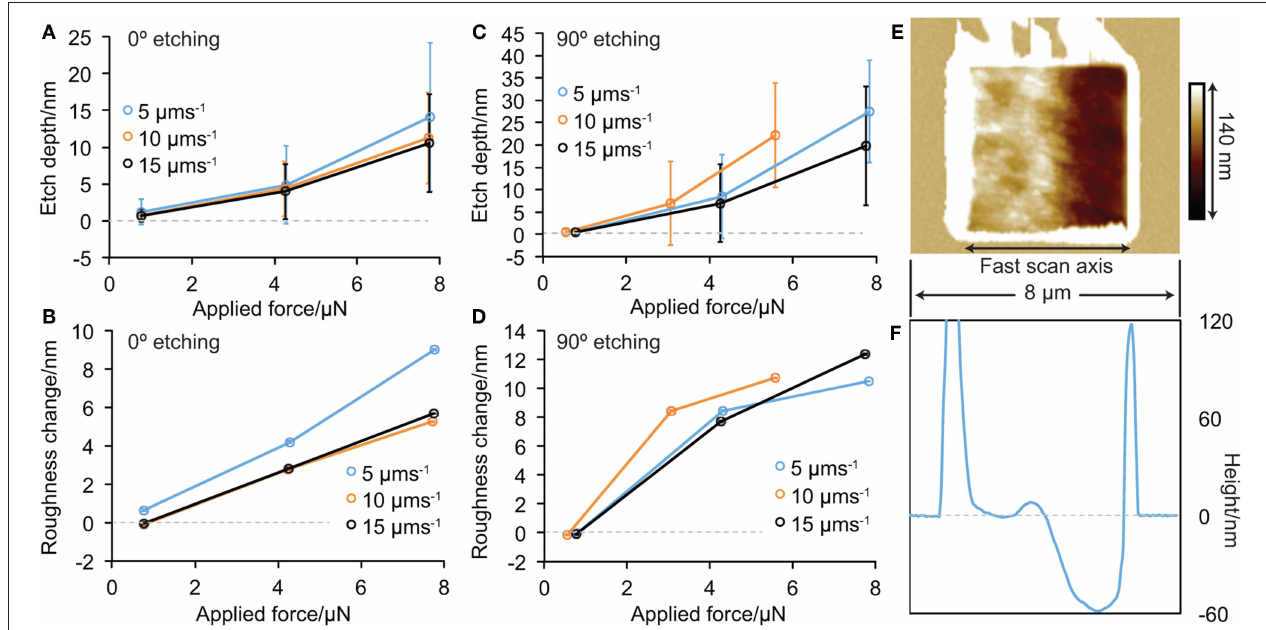
FIGURE 7 | The effect of scan angle and tip speed making five etching passes on 5 µ m × 5 µ m areas on gold with a diamond-coated probe. (A,B) Etch depth and roughness change, respectively, when scanning at 0 ◦ . The slowest speed produces the deepest, roughest trenches. (C,D) Etch depth and roughness change, respectively, when scanning at 90 ◦ . The 90 ◦ processes produce the deeper trenches with a relatively lower roughness. The middle scan speed produces the deepest, roughest, trenches. We note the large error bars in (A,C) , illustrating the large trench roughnesses. (E) Topography of the roughest trench, when etching at 90 ◦ and 15 µ ms − 1 with 8 µ N applied, demonstrating a deep depression perpendicular to the fast scan axis. (F) Step profile across (E) , demonstrating that the deepest part of the trench is over 50nm below the surface, whilst the shallowest part is raised above the